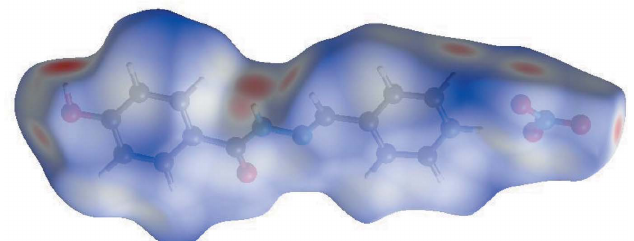
Figure 4 View of the three-dimensional Hirshfeld surface of the title aroyl